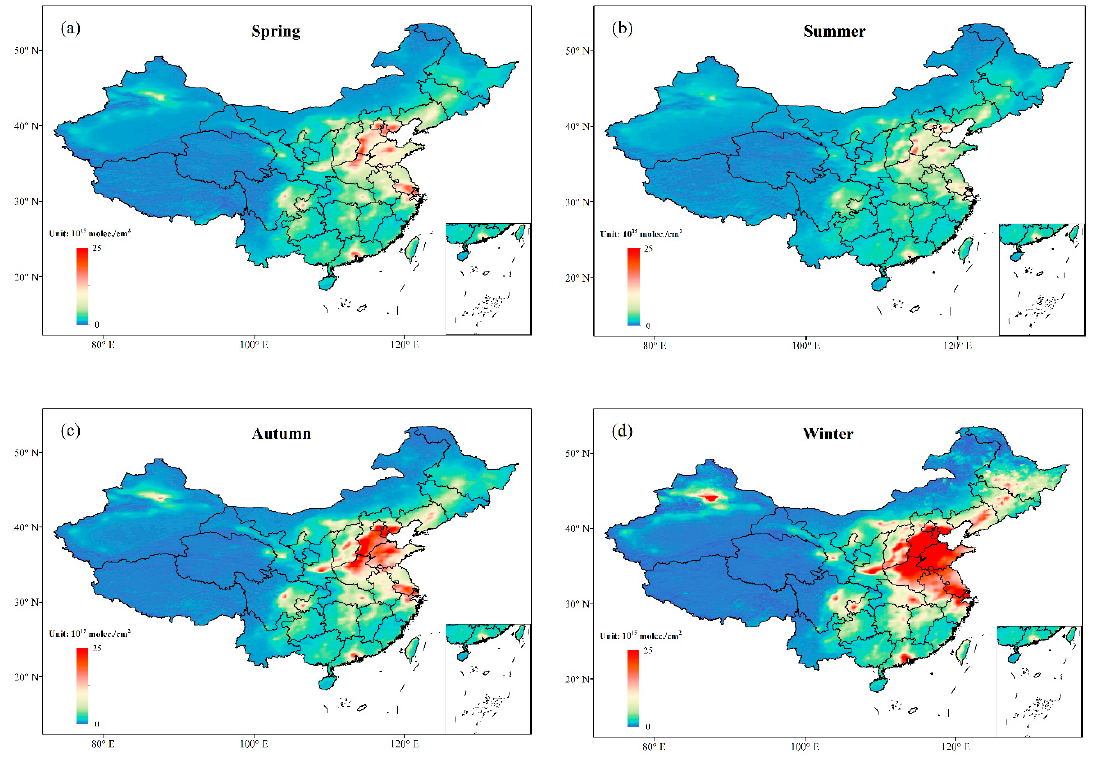
Figure 7. Seasonal NO 2 column over China during 2005–2018 (unit: 10 15 molec cm − 2 ): ( a ) spring; ( b ) summer; ( c ) autumn; and ( d ) winter.